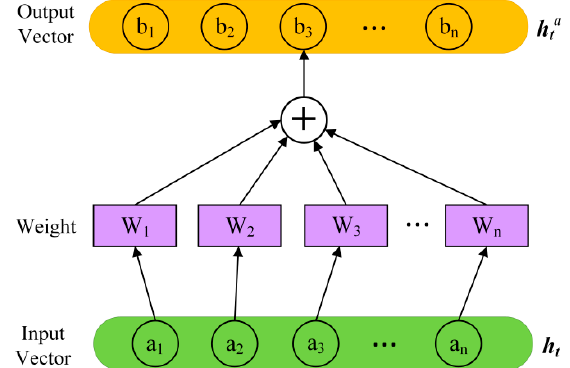
Figure 5. Attention operation depend on Bi-LSTM.